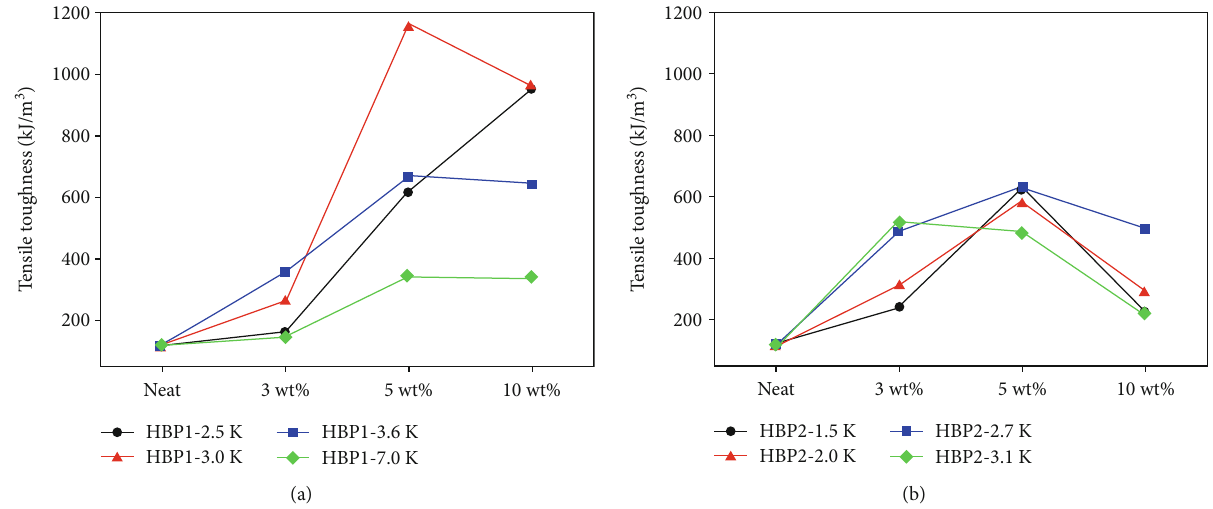
Figure 6: Tensile toughness of (a) epoxy/HBP1 and (b) epoxy/HBP2 blends with di ff erent molecular weights and HBP loadings.